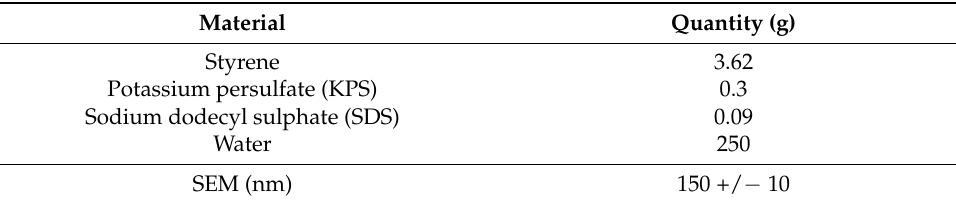
Table 1. The conditions used for the manufacture of polystyrene nanospheres at 80 ◦